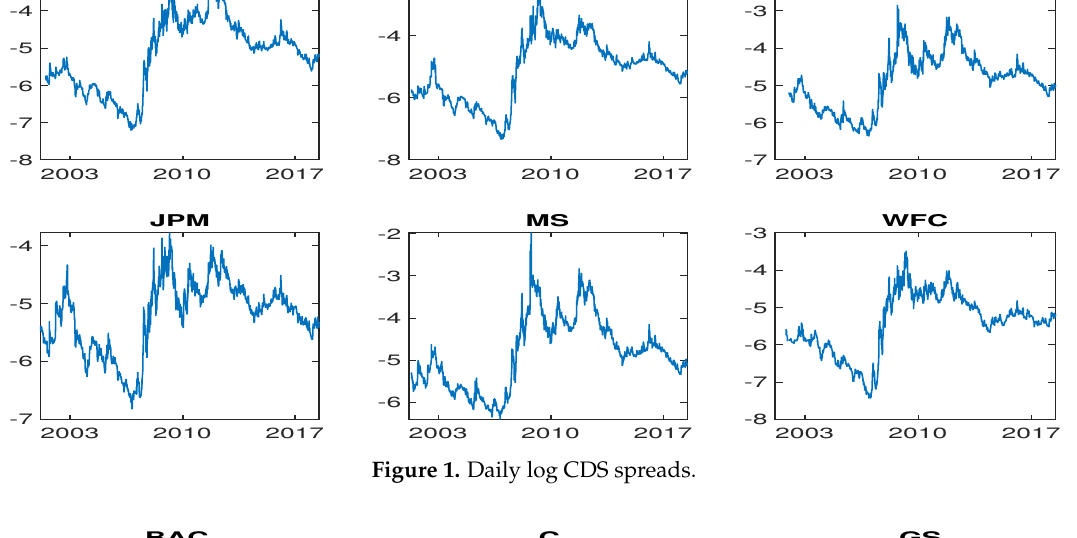
Figure 1. Daily log CDS spreads.